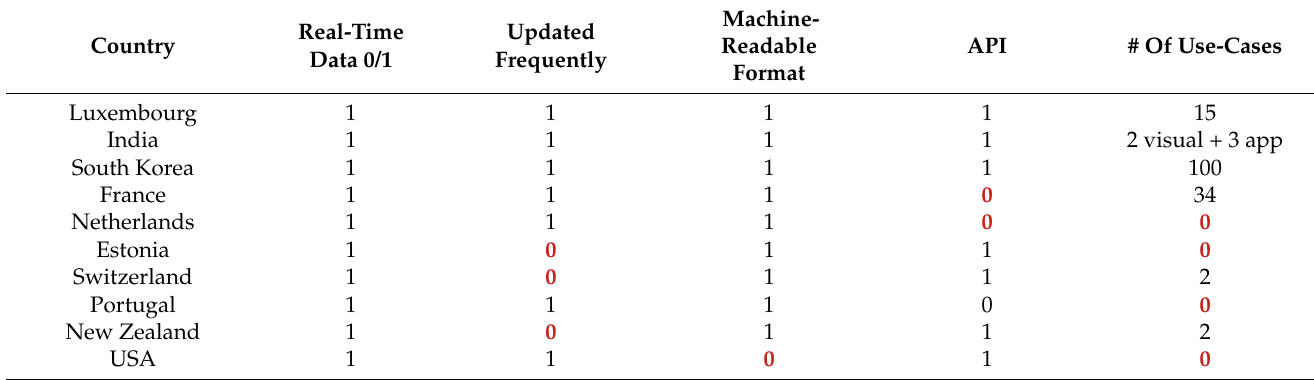
Table 6. Real-time data: TOP-10 OGD